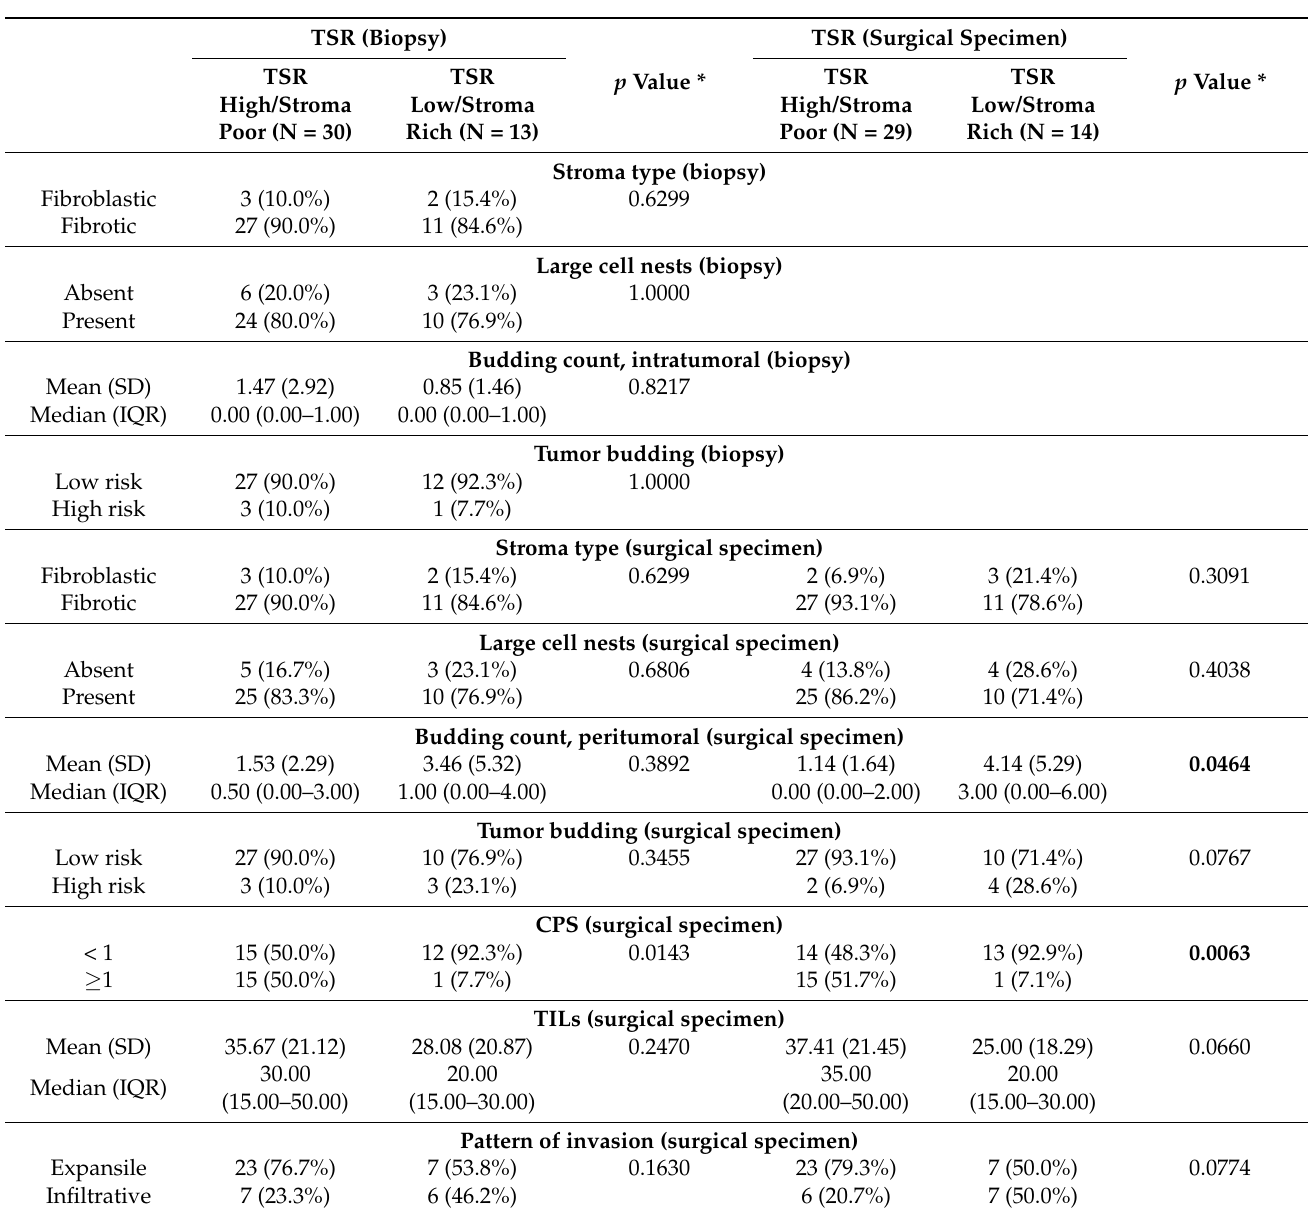
Table 2. Association between clinical–pathological variables and TSR on both biopsies and surgical